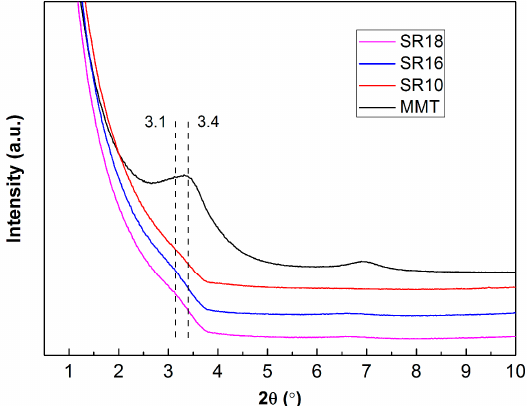
Figure 3. X-ray diffraction (XRD) patterns for Charex.44PSS MMT and the composites containing MMT or SiCw/MMT fillers.